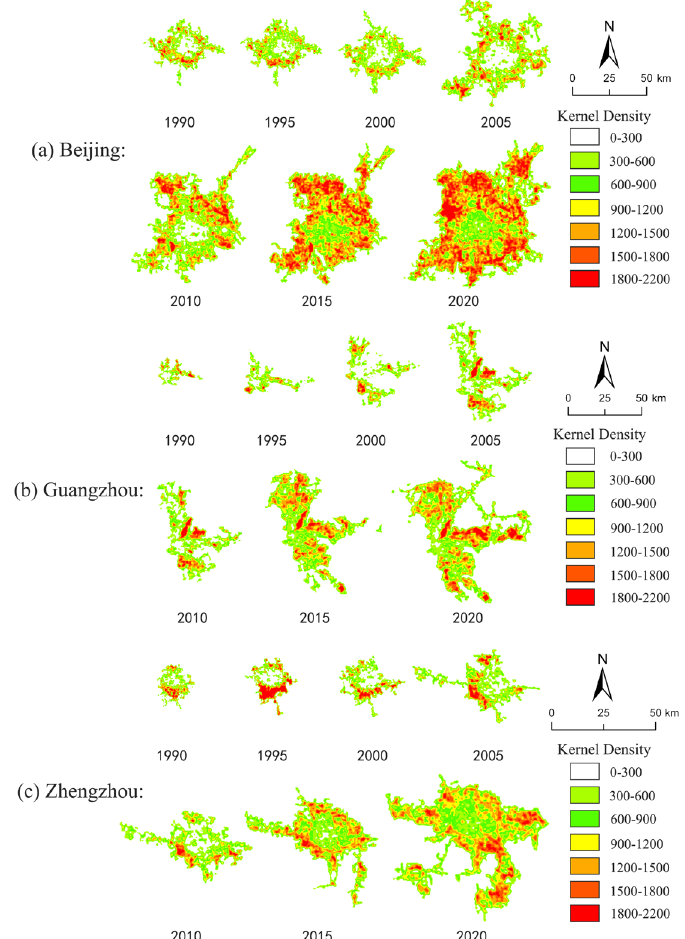
Figure 5. Distribution map of kernel density of vegetation in Beijing’s ( a ), Guangzhou’s ( b ), Zhengzhou’s ( c ), built-up area from 1990 to 2020.